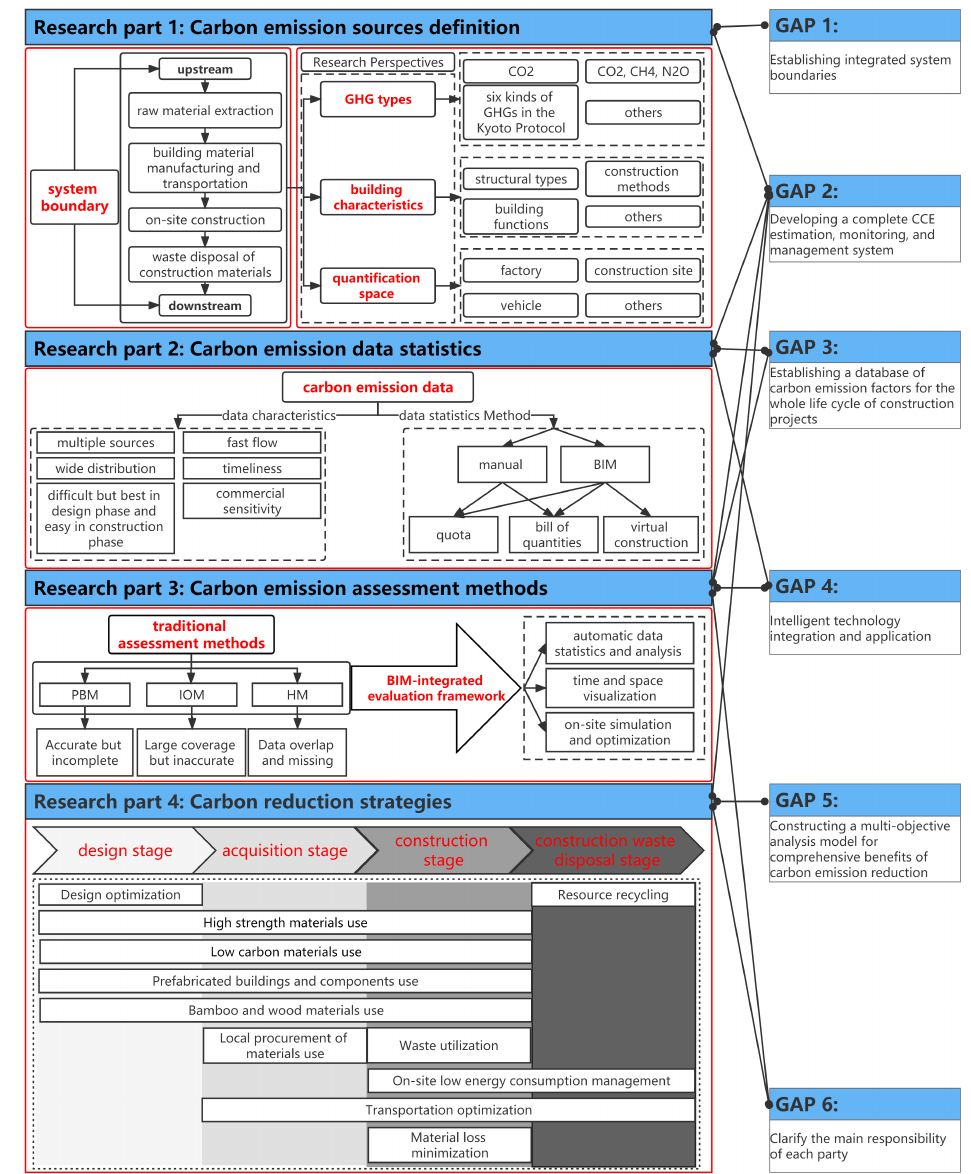
Figure 8. Knowledge map for construction phase carbon emissions